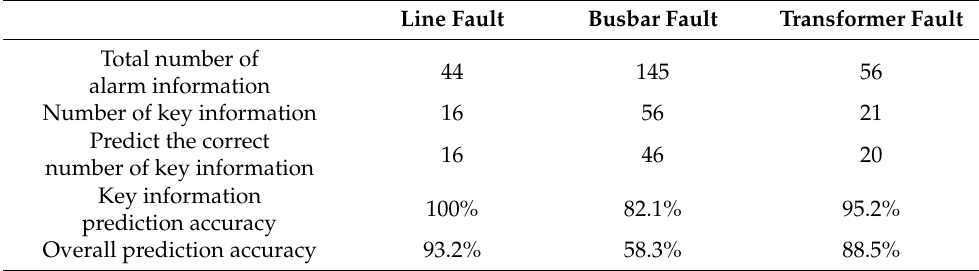
Table 5. Sample diagnosis results.